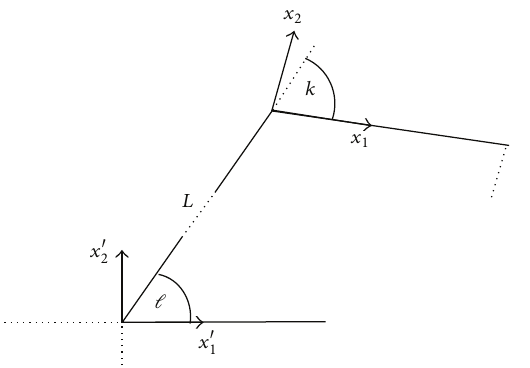
Figure 1: The arms of winch as a double